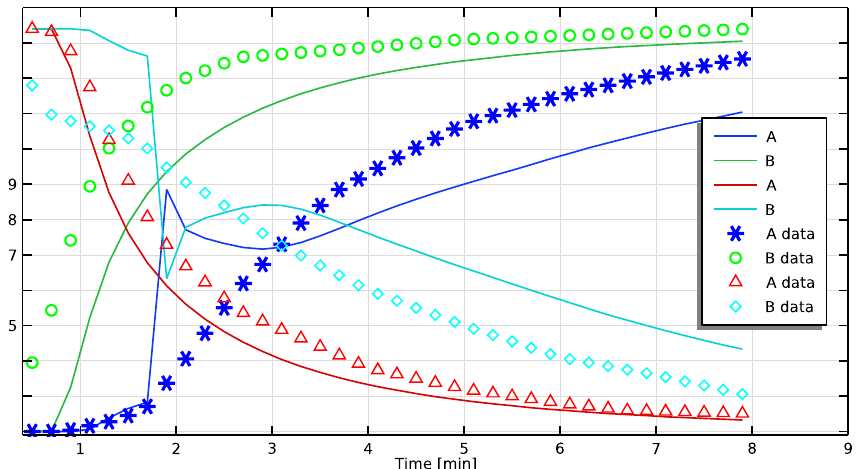
Figure 10. Comparison between measurements and numerical results, at two observation points, A and B, for the heating and cooling stages, for T 0 = 22 °C and T 1 = 95 °C , with con- stant